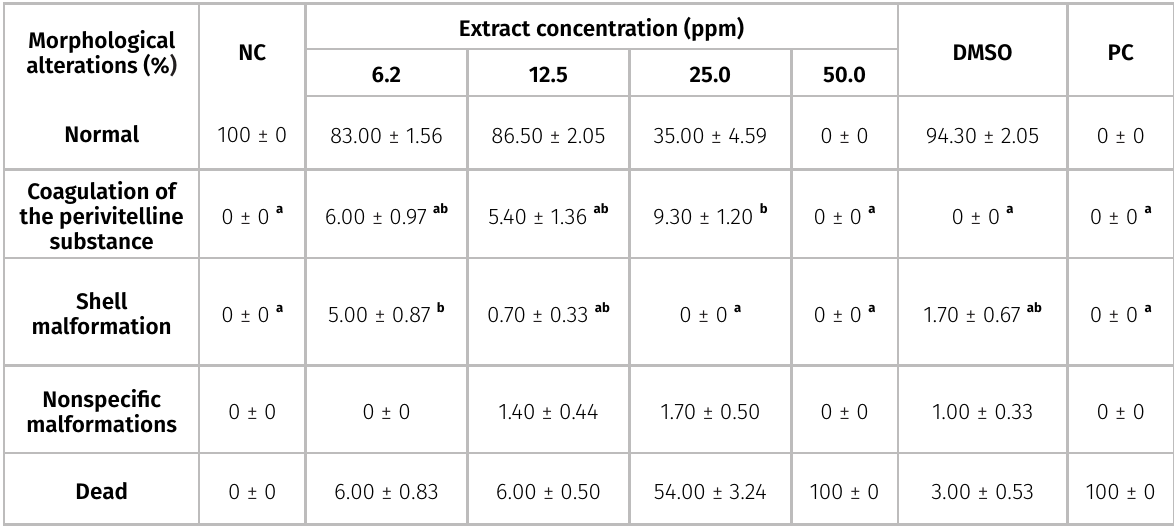
Table II. Morphological alterations and mortality frequency (%) of Biomphalaria glabrata embryos after exposure to the crude ethanolic extract of the Persea americana stem bark for 144 h. Results are expressed as mean ± standard deviation. One-way ANOVA followed by Tukey’s multiple comparisons test. Different letters indicate differences between groups (p < 0.05). (NC) Negative control. (PC) Positive control (niclosamide); (DMSO) Dimethylsulfoxide – solvent